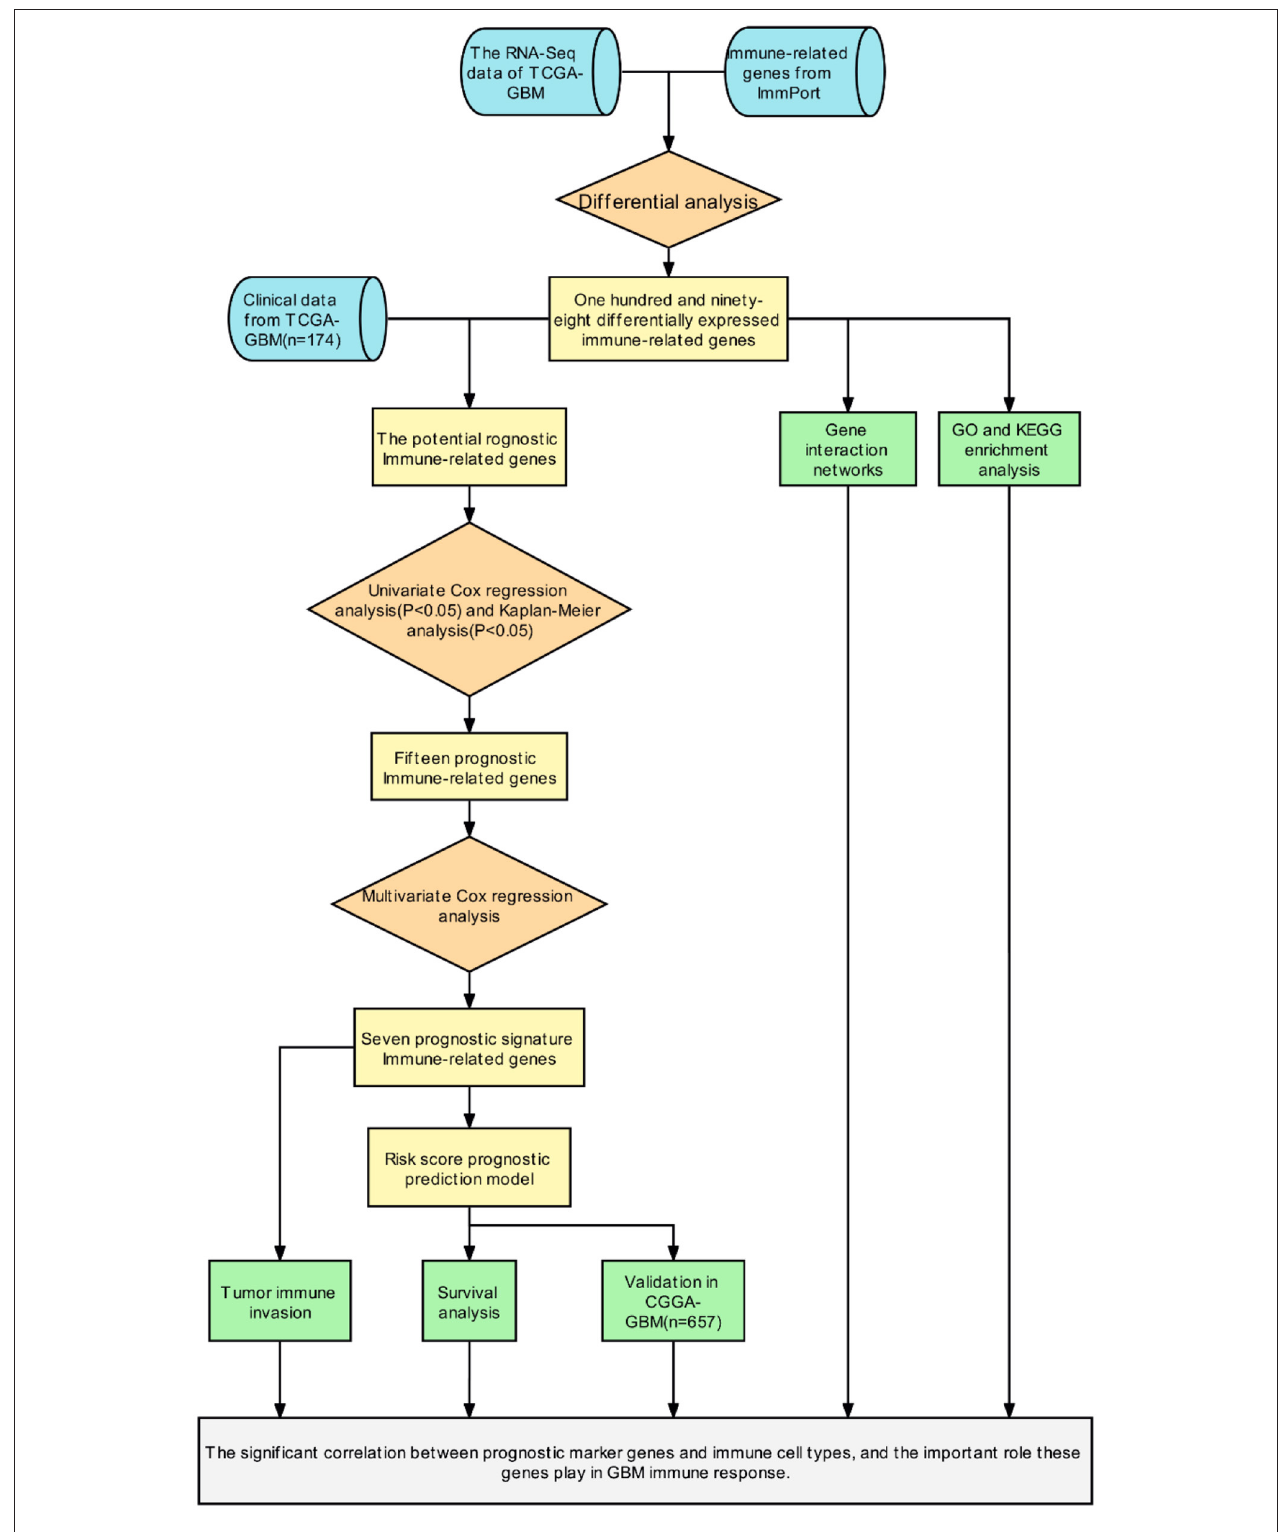
FIGURE 1 | The flow chart of the study protocol.